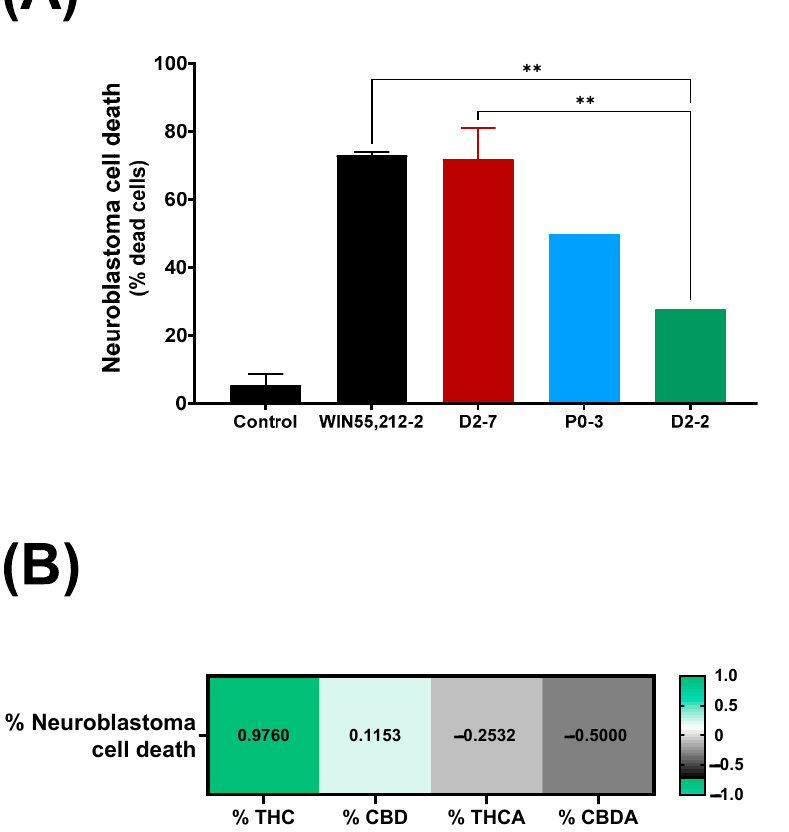
Figure 2. ( A ) Neuroblastoma cell death upon exposure to different Cannabis plant extracts (final concentration of each plant extract was 3.5 µ g/mL), in control situation and exposed to WIN55,212- 2 synthetic cannabinoid (3.5 µ g/mL). Each condition was analyzed per duplicate. A one-way ANOVA with Tukey’s post-hoc was performed, with α set as 0.05, two-tailed. p -value < 0.01 (**). ( B ) Pearson correlation between neuroblastoma cell death expressed as percentage, and quantity of tetrahydrocannabinol, cannabidiol, tetrahydrocannabinol A (THCA), and cannabidiol A (CBDA), expressed as percentage.